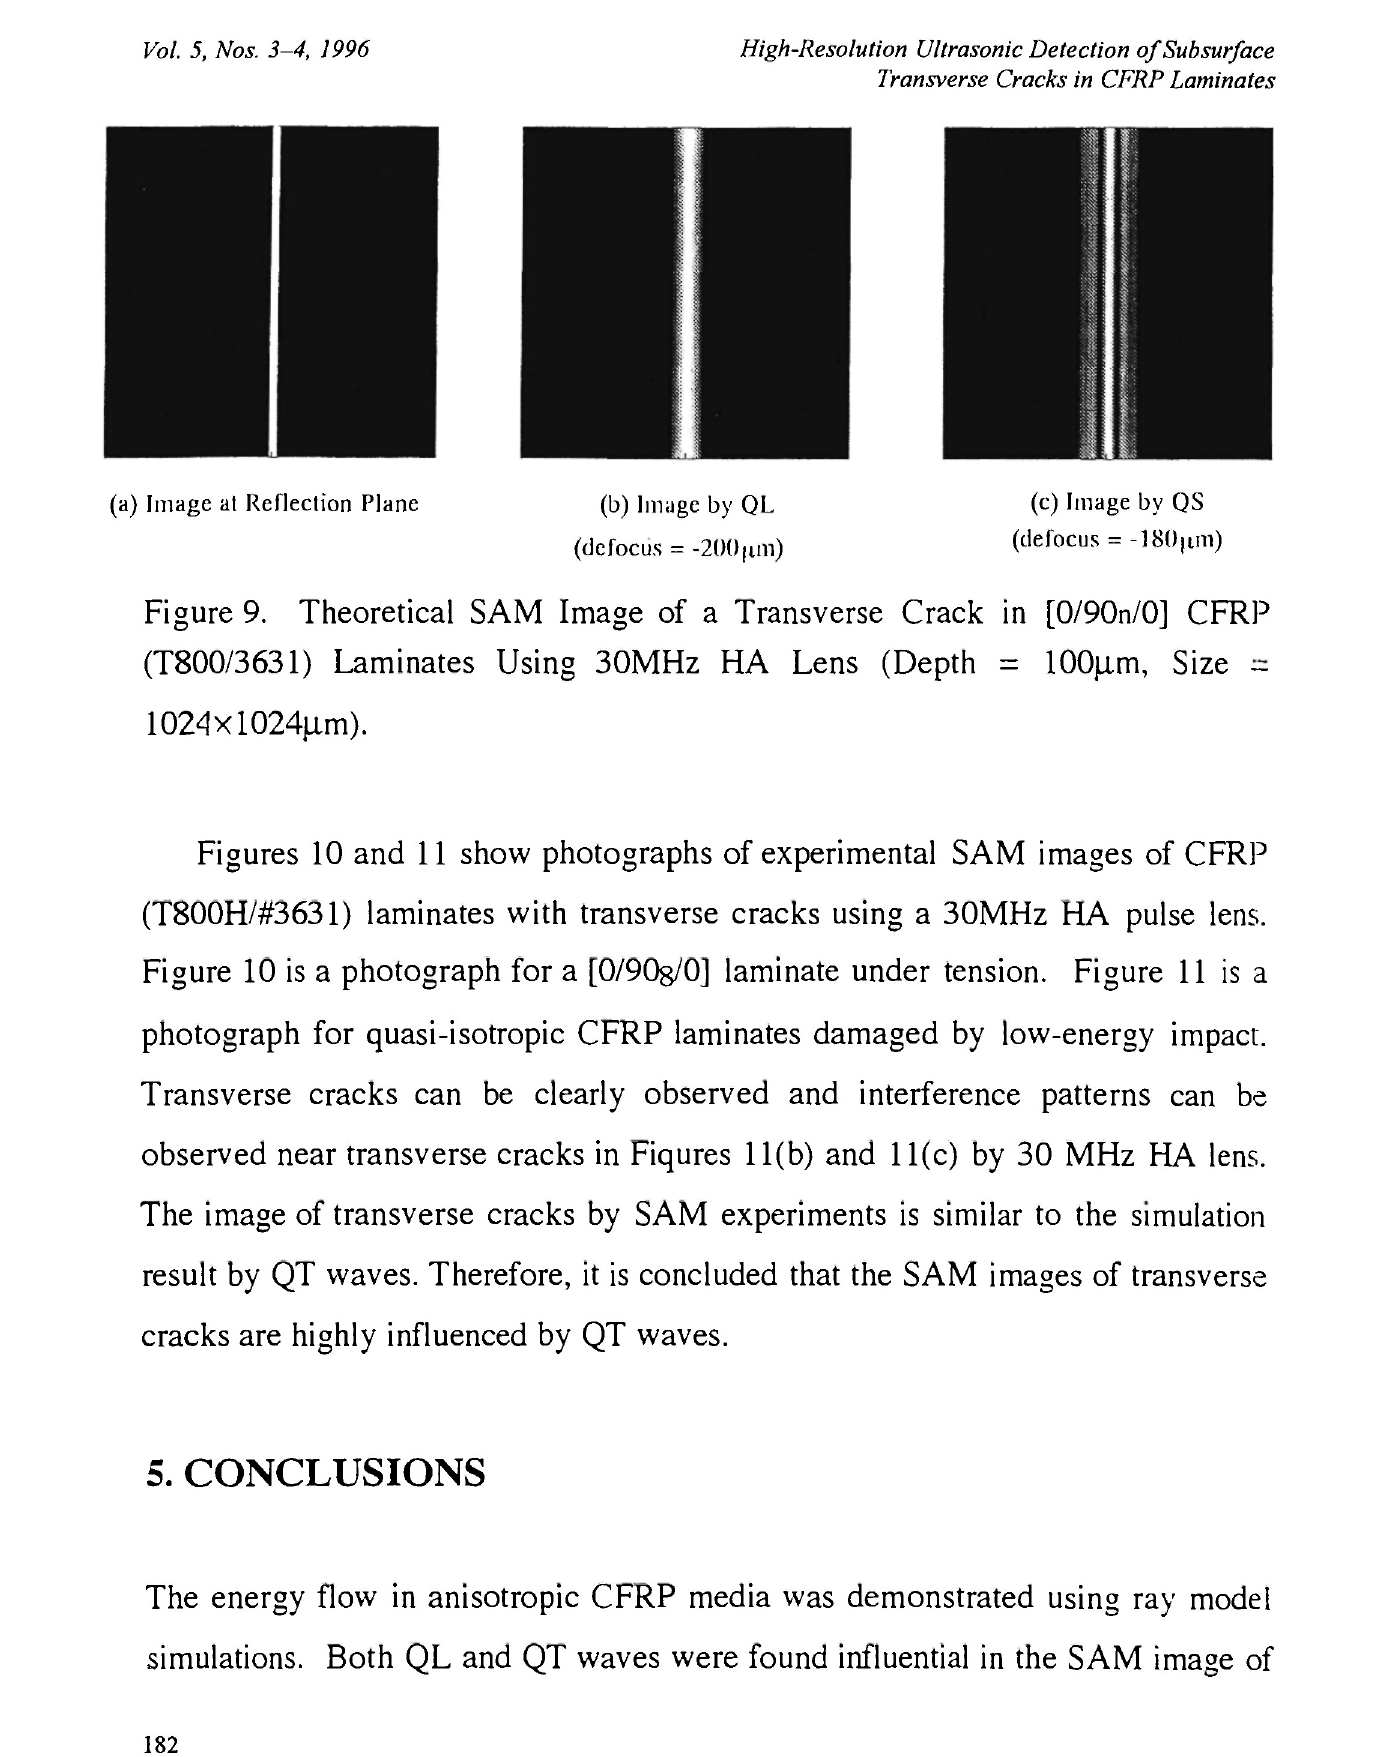
Figure 9. Theoretical SAM Image of a Transverse Crack in [0/90n/0] CFRP (T800/3631) Laminates Using